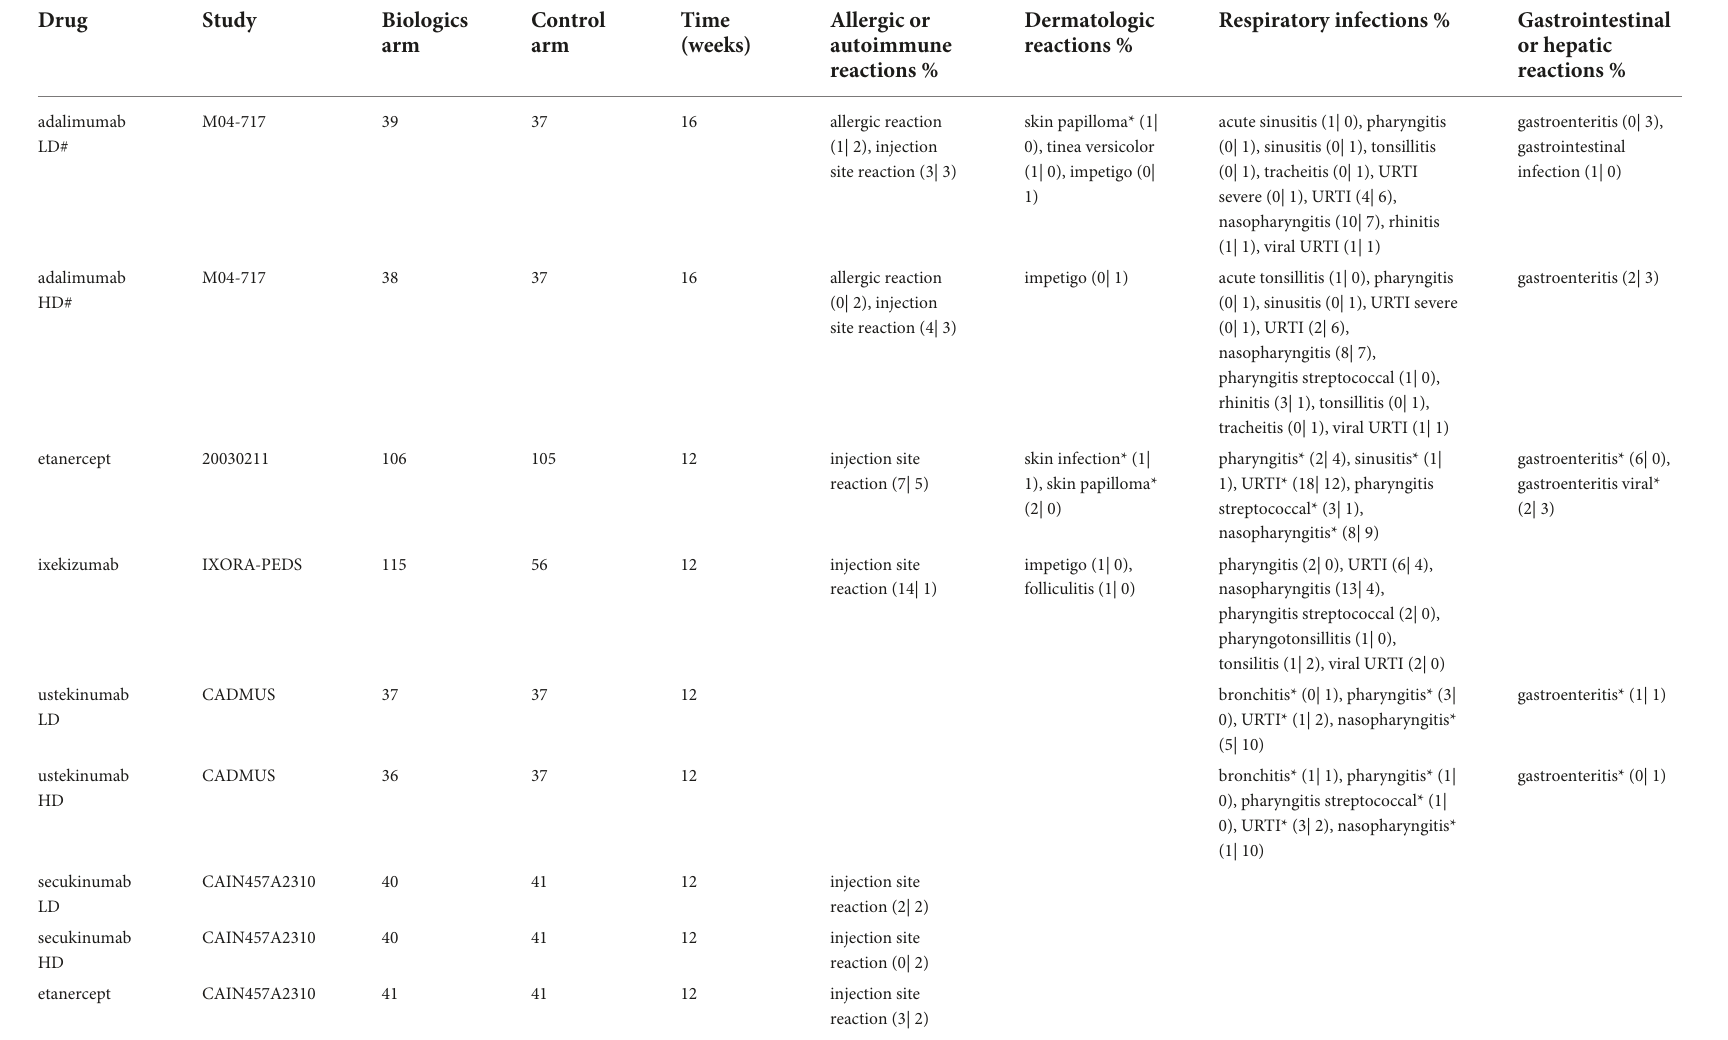
TABLE 4 Overview of adverse events of interest in RCTs in children with